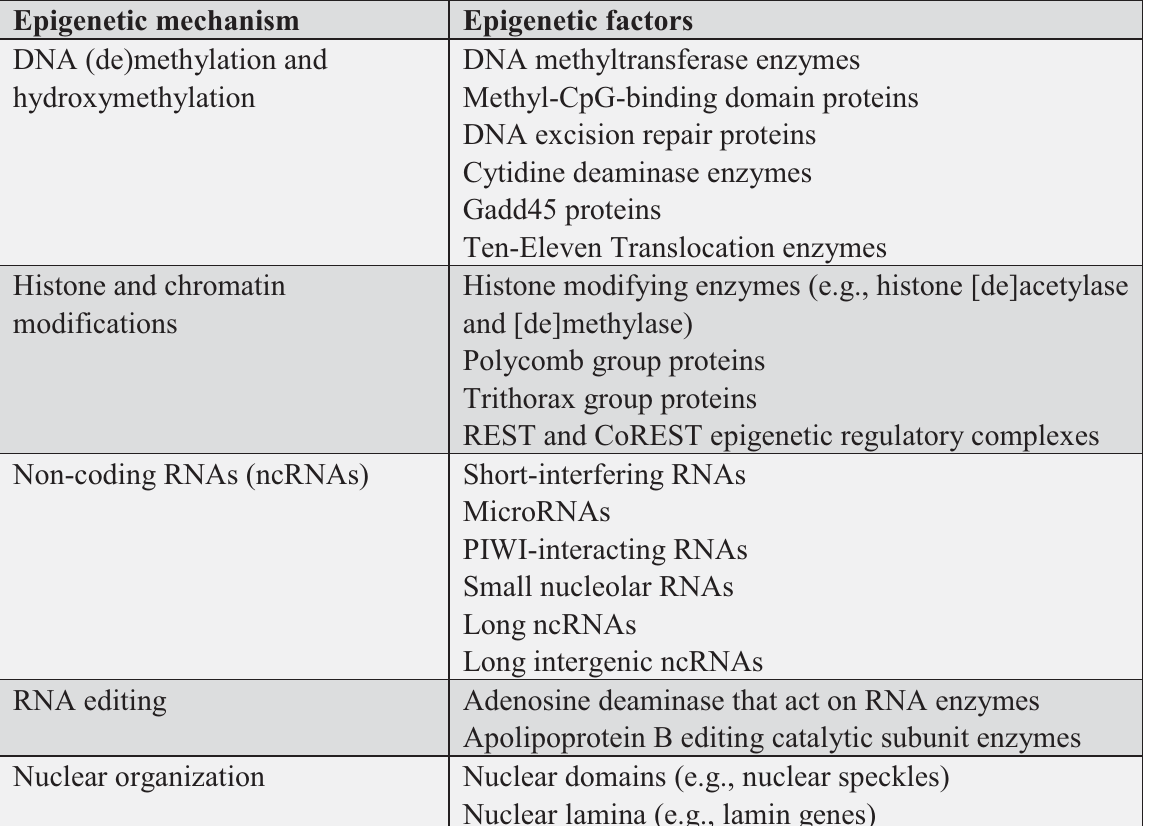
Table 1. Principal epigenetic regulatory mechanisms and associated examples of factors implicated in mediating these